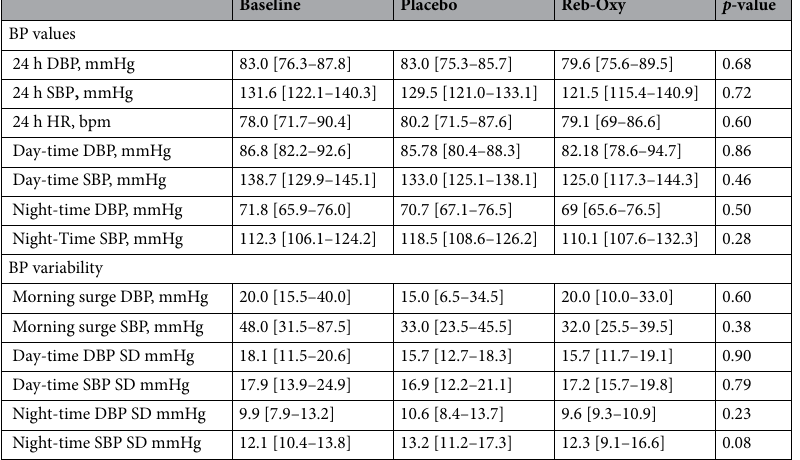
Baseline Placebo